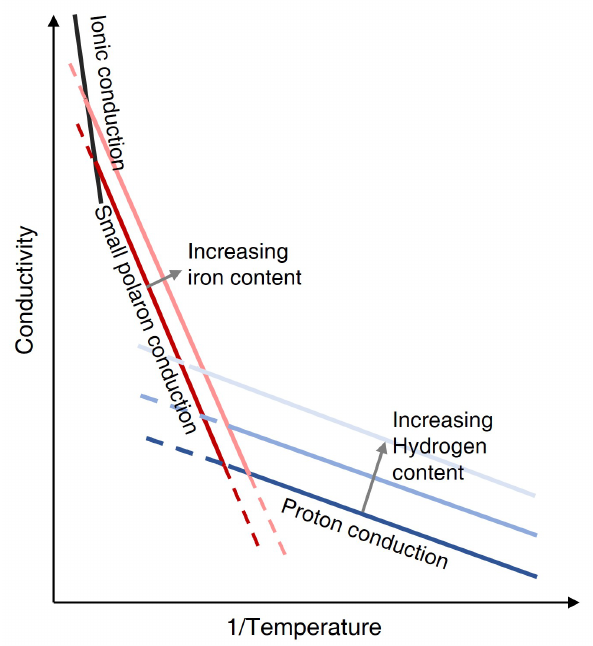
Figure 2. The change of silicate minerals conduction mechanism with temperature [40]. The specific temperature and conductivity is compositionally